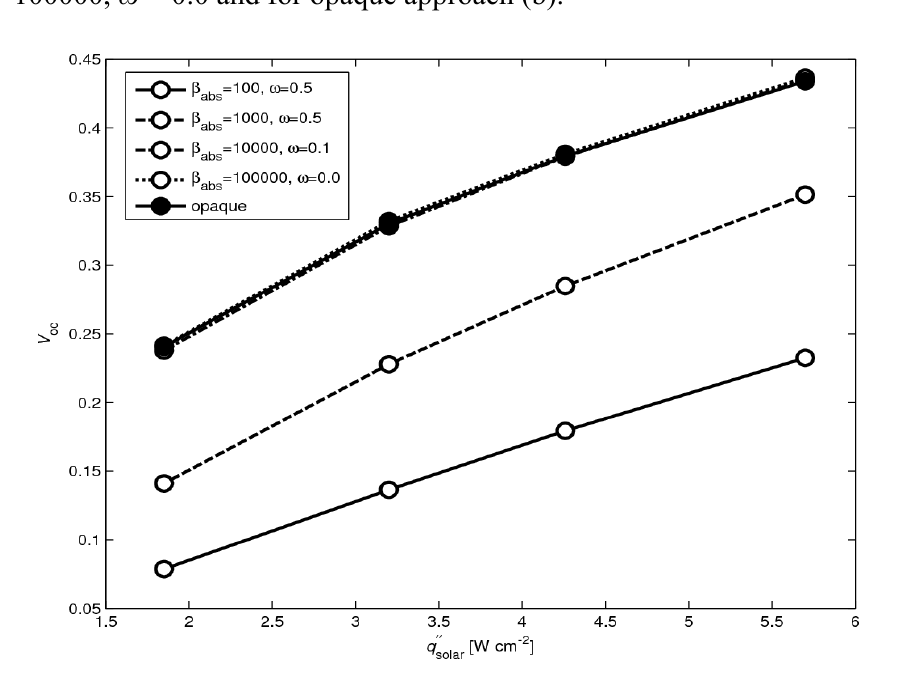
= 10000, ω = 0.1; absorber